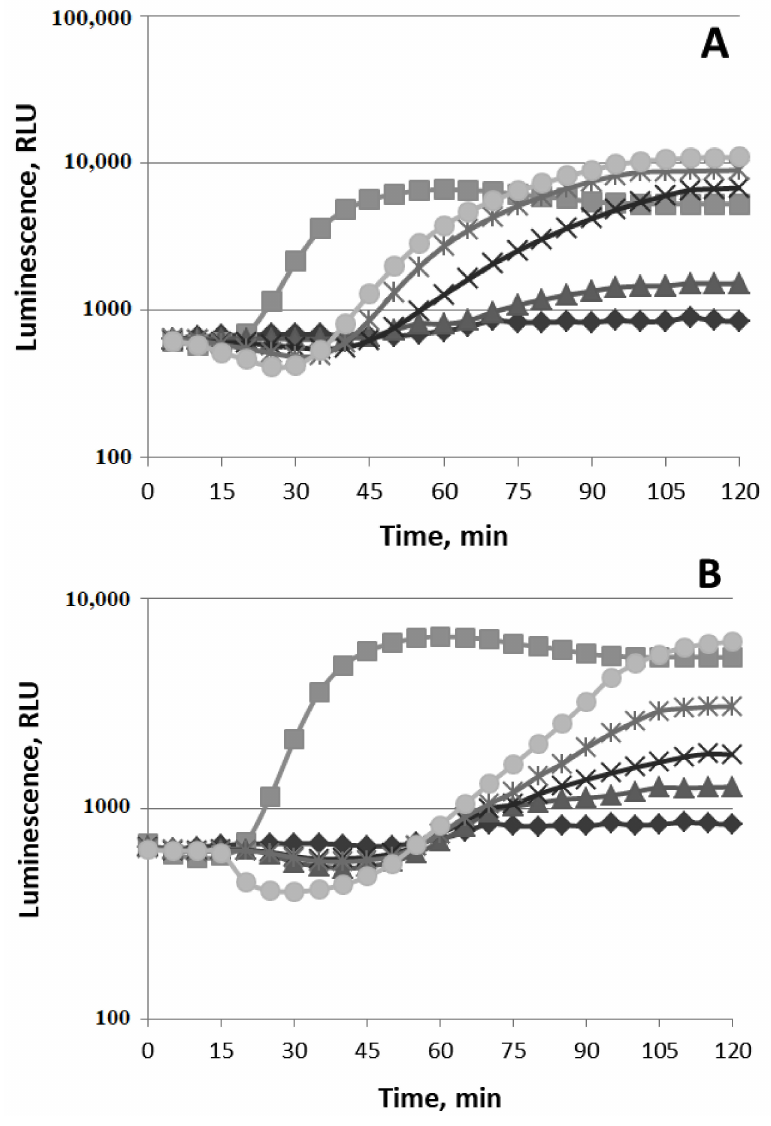
Figure 2. Luminescent response of strain E. coli MG1655 (pKatG’::lux) to hydrogen peroxide ( A ), ( − )-limonene ( B ), and (+)- α -pinene (C). Time course of mean values of light emission (in RLU) in the presence of different chemical concentrations ( A , B ): ( ) 0 µM (black diamond—Control), ( ) 1 Figure 7. Luminescence response of E. coli MG1655 (pIbpA’::lux) (“heatshock”) to( − )-limonene µM (gray square), ( ) 5 µM (dark triangle), (×) 25 µM (black cross), (  ) 50 µM (gray asterisk), and ( A ) and (+)- α -pinene ( B ). Kinetics of changes in mean values of light emission (in RLU) at various chemical concentrations: ( A , B ): ( ( ) 100 µM (light circle); (C): ( ) 0 µM (black diamond—control), ( ) 5 µM (light square), ( ) 50 µM (gray triangle), ( ) 100 µM (black